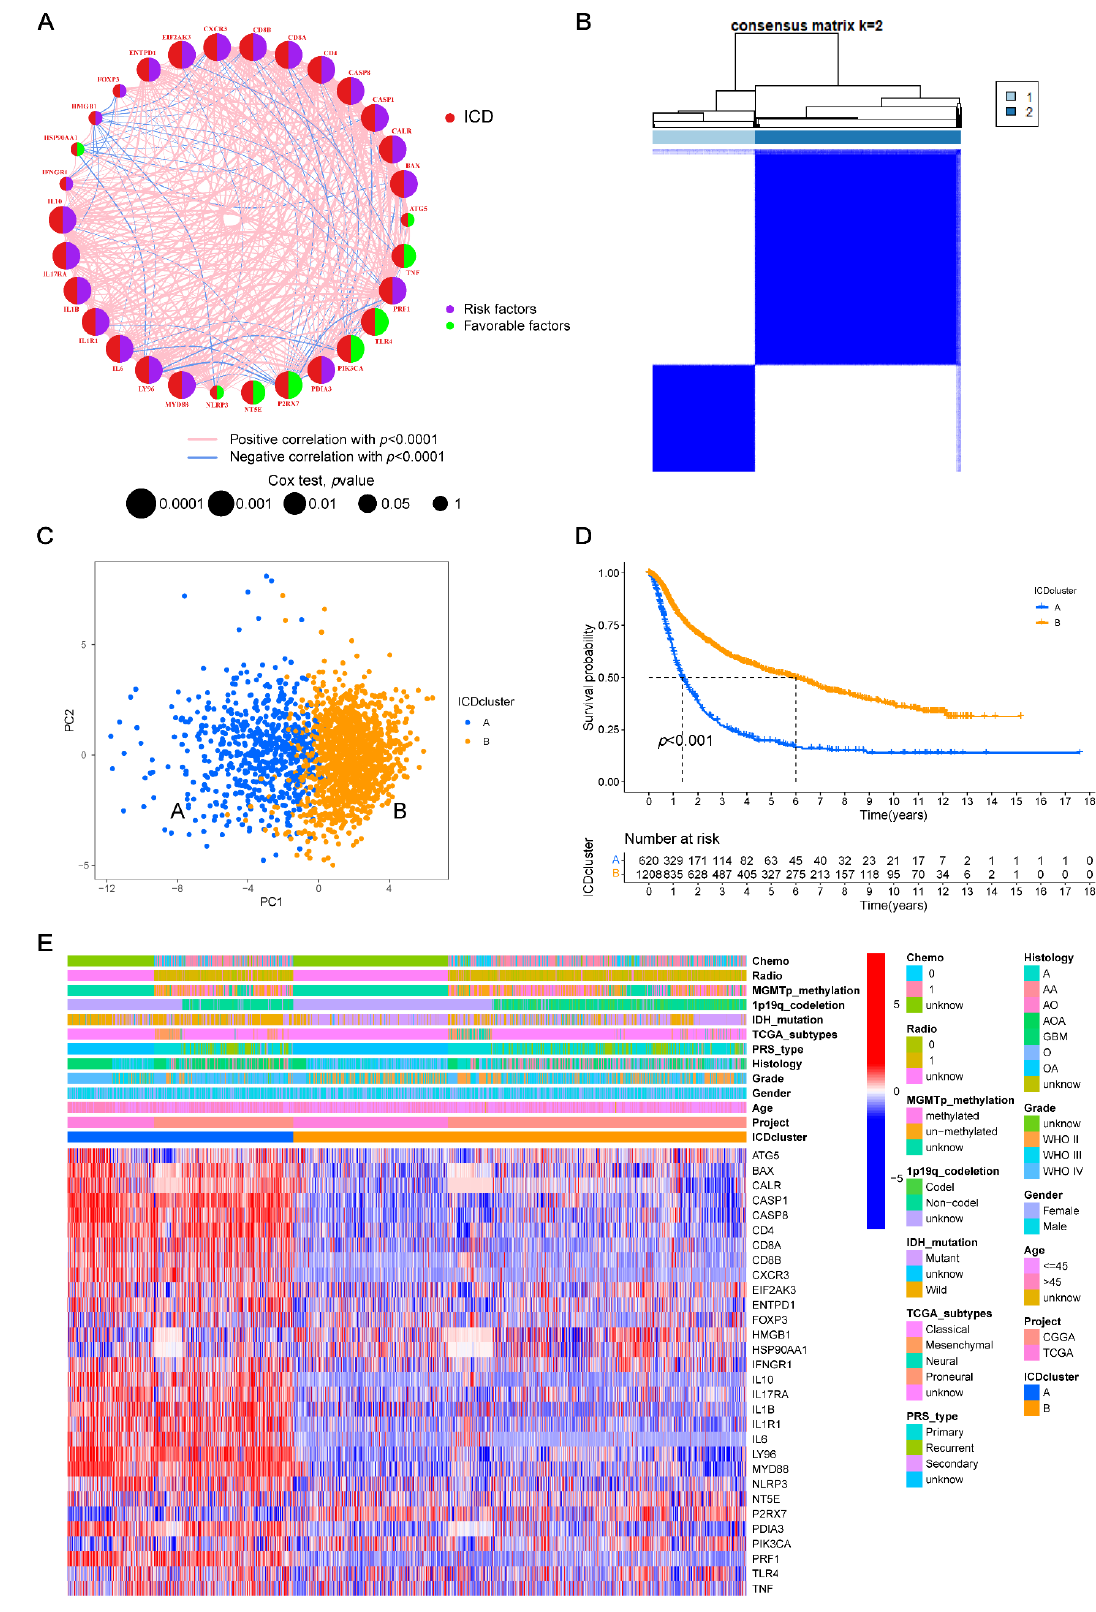
Figure 2. ICD-related gene clusters and clinicopathological and biological features of two